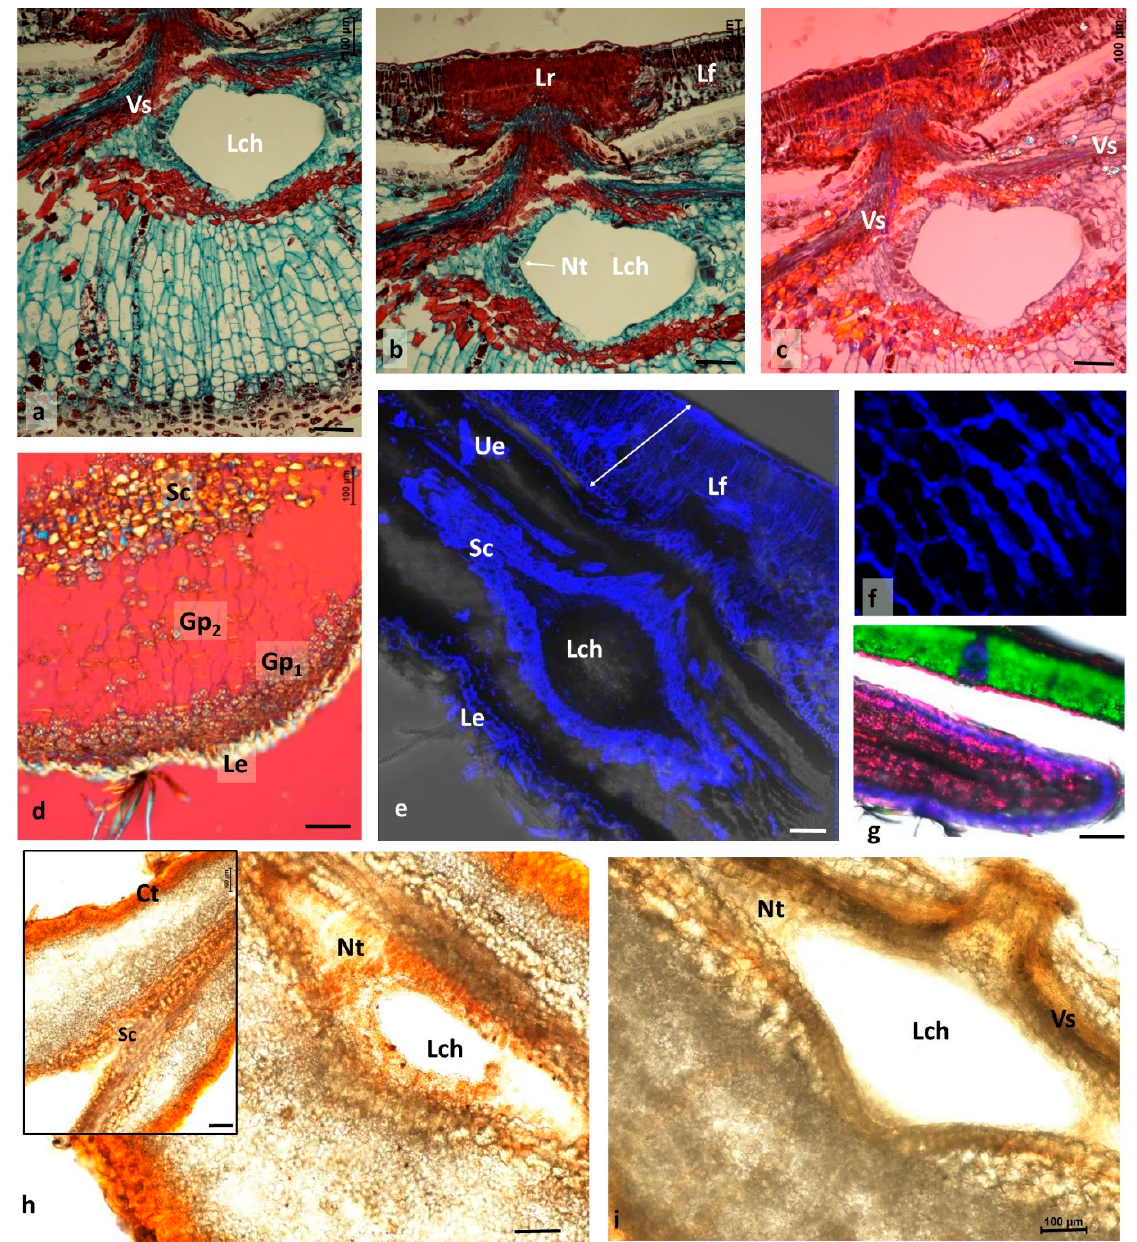
Figure 5. Autumn spangle gall (LM and FM—polarized light; a–c fast green and safranine). ( a ) Cross-section through the centre of the mound. Dark red, lignified parts; Vs, vascular strands; Lch, larval chamber. ( b , c ) Cross-section through the place of coalescence (Lr) between gall tissue and leaf; Nt, nutritive tissue; ( b ) normal light; ( c ) polarized light. ( d ) Cross- section through the mound of the gall. Starch accumulated near the epidermis (Gp 1 ); in the centre, it rarely occurred (Gp 2 ). ( e ) Cross-section through gall and sustaining leaf (FM, blue—lignin autofluorescence). Arrow with two heads, leaf tissue; Ue, adaxial epidermis ; Le, abaxial epidermis; Sc, sclerenchyma. ( f ) Abaxial epidermis (FM), mainly anticlinal walls, lignified (blue). ( g ) Marginal part of a gall and sustaining leaf in cross-section. (FM) Green, strong green autofluorescence of leaf chlorophyll; blue, lignin autofluorescence; pink, tannin autofluorescence. ( h ) Cross-section through larval chamber (stained with Sudan III); orange-red coloration, lipids (including cutin and waxes). Insert, another place in the same gall; ( i ) cross-section through larval chamber stained with KNO3—yellow–grey, the proteins. Bars represent 100 μ m. Localization of lignified elements in an autumn gall and in its sustaining leaf is shown in Figure 5e. Adaxial cell walls were lignified, especially the abaxial epidermis and the inner leaf cells (palisade and spongy parenchyma) situated near the gall stalk. Strongly lignified was also the sclerenchymatous lenticular capsule in cross-section surrounding the larval chamber. In the abaxial epidermis of the gall (Figure 5f), mainly the anticlinal